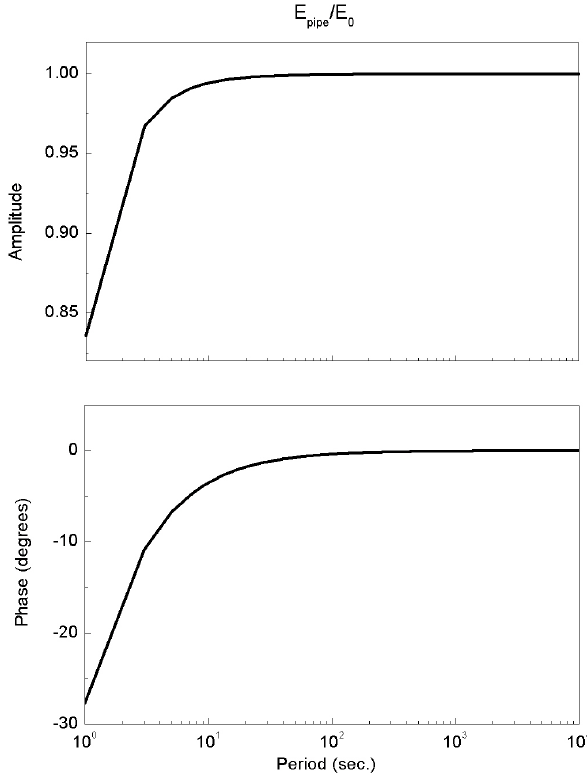
Fig. 5. Ratio between the electric field in the pipe steel and the electric field in the ground for the Norman Wells – Zama